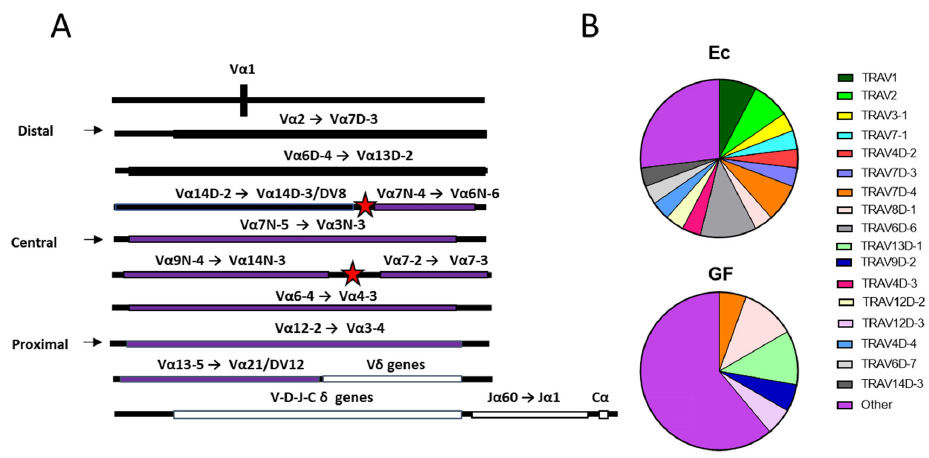
Figure 3. TCR distal V α usage among REP sequences in Ec and GF mice. ( A ) Relative gene fragment positions are shown. Maps were based on information from the IMGT website [3]. Three sections of genes (distal, central, proximal) are separated by red stars. Distal V α gene positions are shown in black, while central and proximal gene positions are shown in purple. TCR δ genes and J α /C α genes are shown in white ( B ) Distal V α sequence usage among REP sequences in Ec and GF mice from the three combined experiments are shown. There were 26 TCR α REP sequences in Ec mice and 18 TCR α REP sequences in GF mice. Distal V α sequences are named and color-coded. Central and proximal sequences are termed ‘other’ and shown in purple. Analyses of all REP sequences from the three experiments combined showed significantly more distal V α usage in Ec mice compared to GF mice among REPs ( p = 0.032). When unique TCR V α sequences were examined, there was again a significantly higher frequency of distal V α sequences in Ec mice compared to GF mice. The